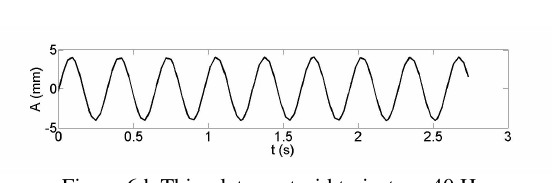
Figure 6d. Thin plate centroid trajectory-40 Hz